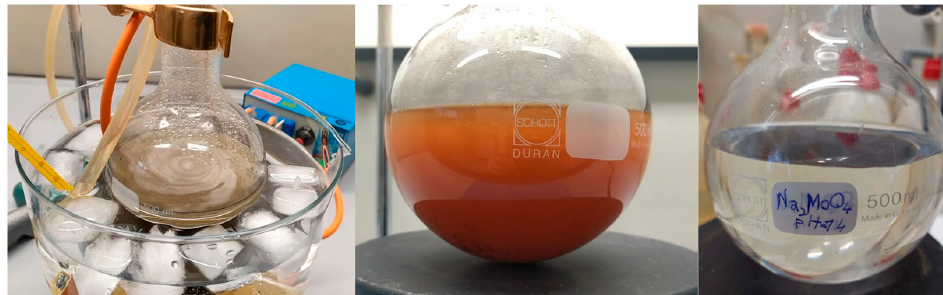
Figure 2. Images of the dissolution process of the molybdenum